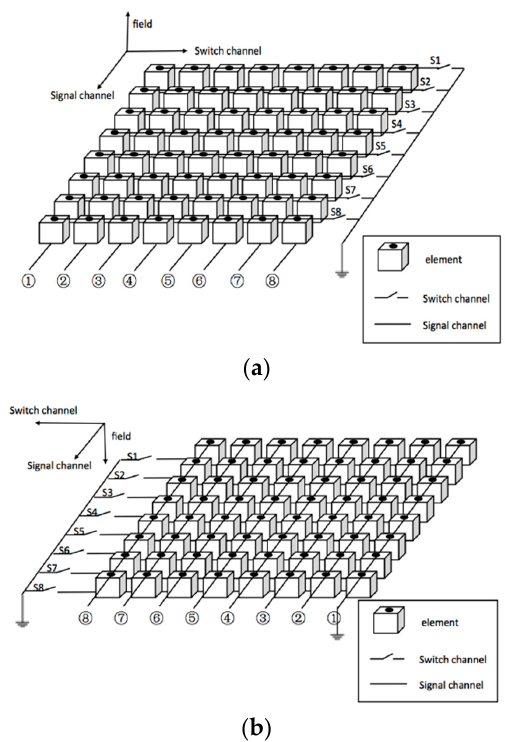
Figure 1. The row-column addressing scheme for an 8 × 8 array: ( a ) obverse side and ( b ) reverse side.